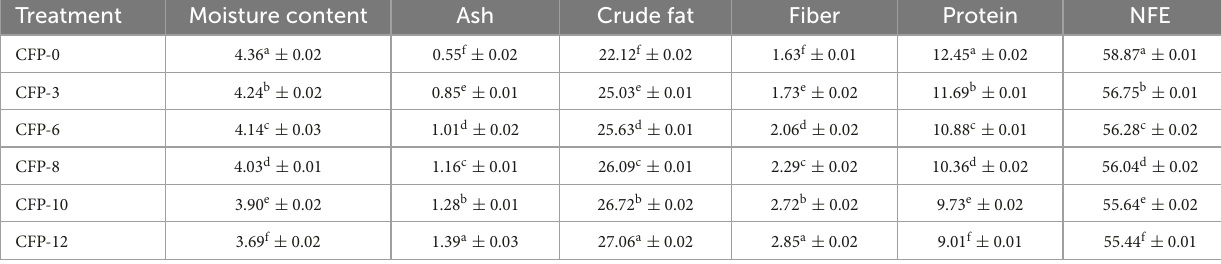
TABLE 3 Proximate composition (%) of cookies fortified with pomegranate peel (PP) powder.